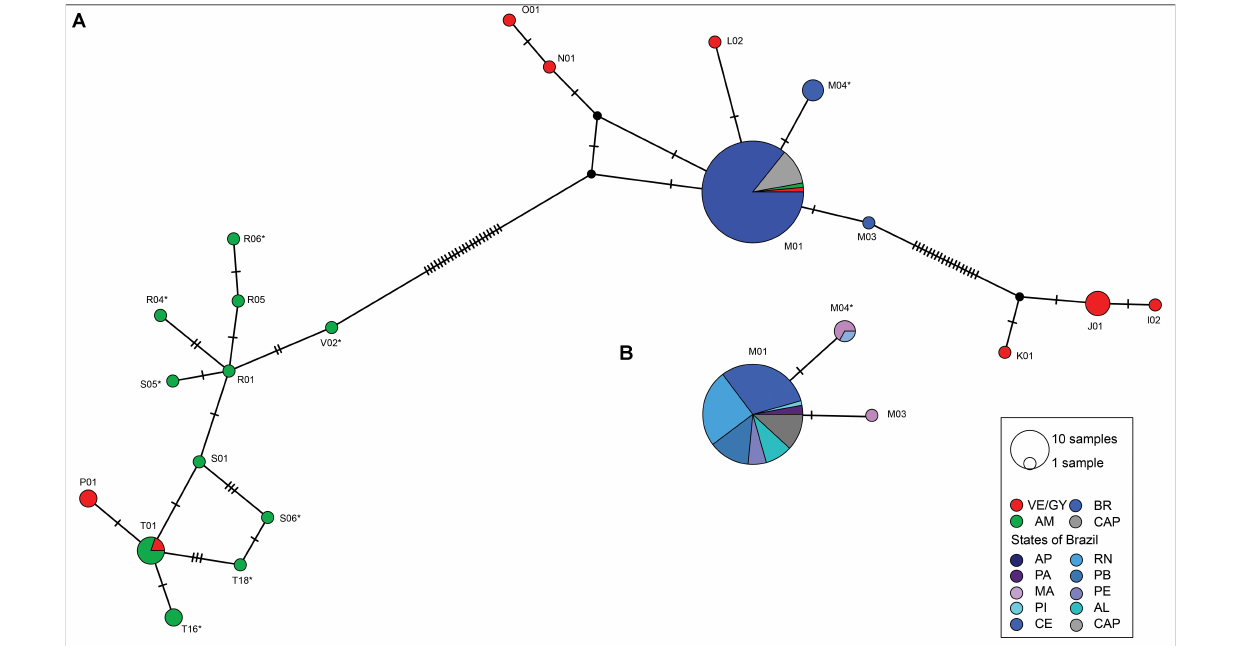
Frontiers in Marine Science |